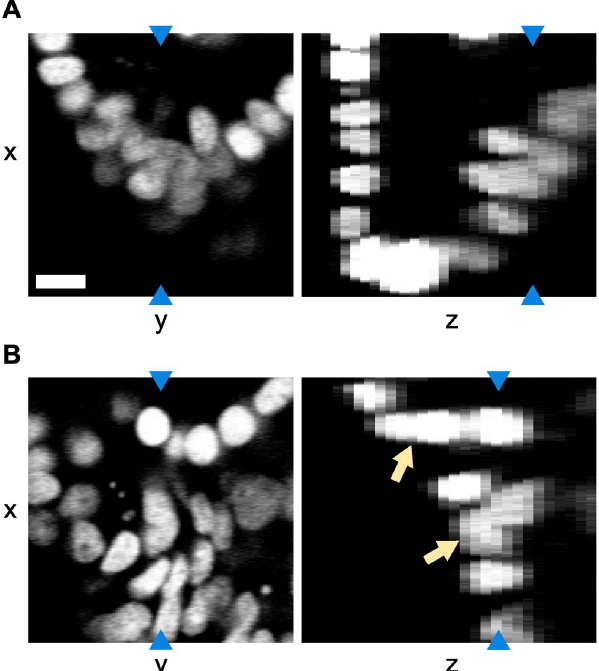
Fig 1. Example of a tracked organoid. Microscopy image slices in the xy and xz planes using H2B-mCherry to visualize the cell nuclei. Blue arrows indicate that both image slices in the same panel represent the same pixels. Note that the resolution in the z-direction is lower. The images show that there is both variation in intensity and visual overlap in the nuclei (indicated by the orange arrows), especially in the z-direction. The scale bar is 10 μ m.